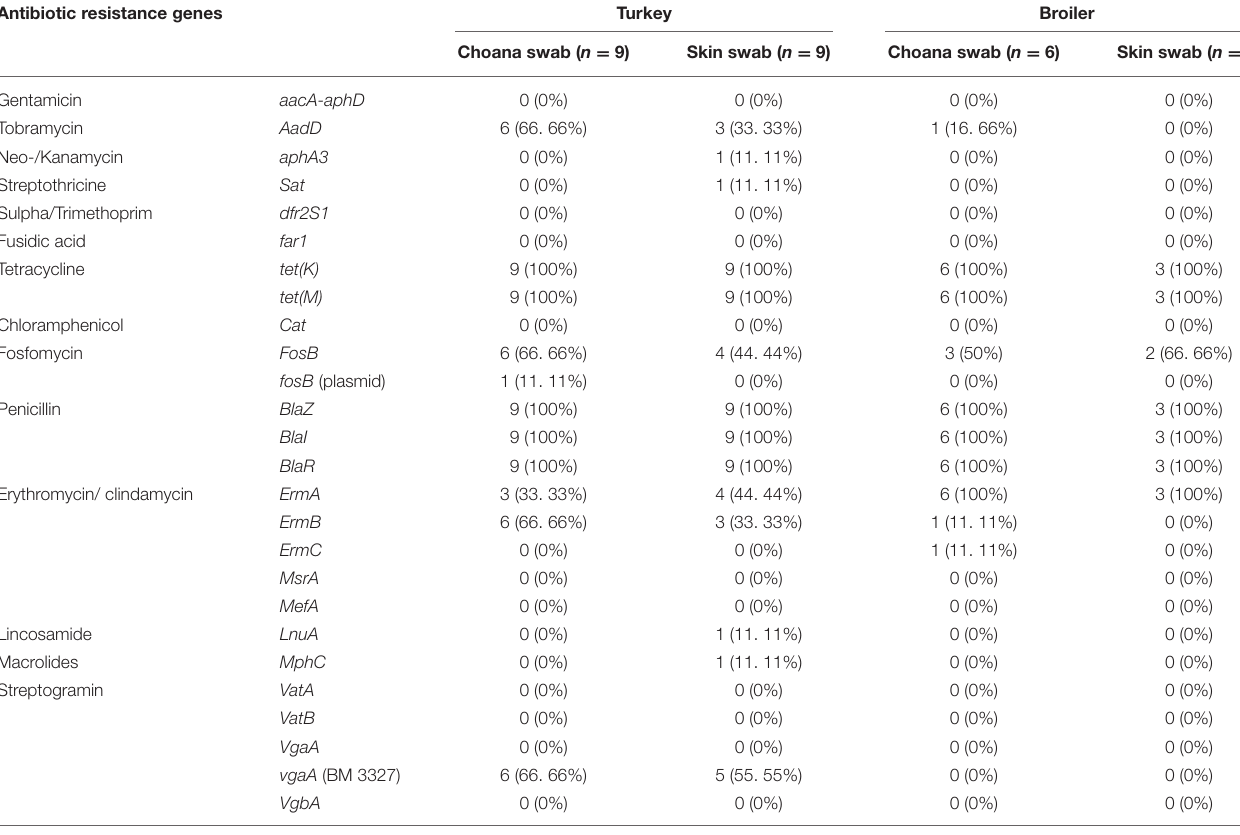
TABLE 4 | Antibiotic resistance of S. aureus isolates based on detection of specific genes. Antibiotic resistance